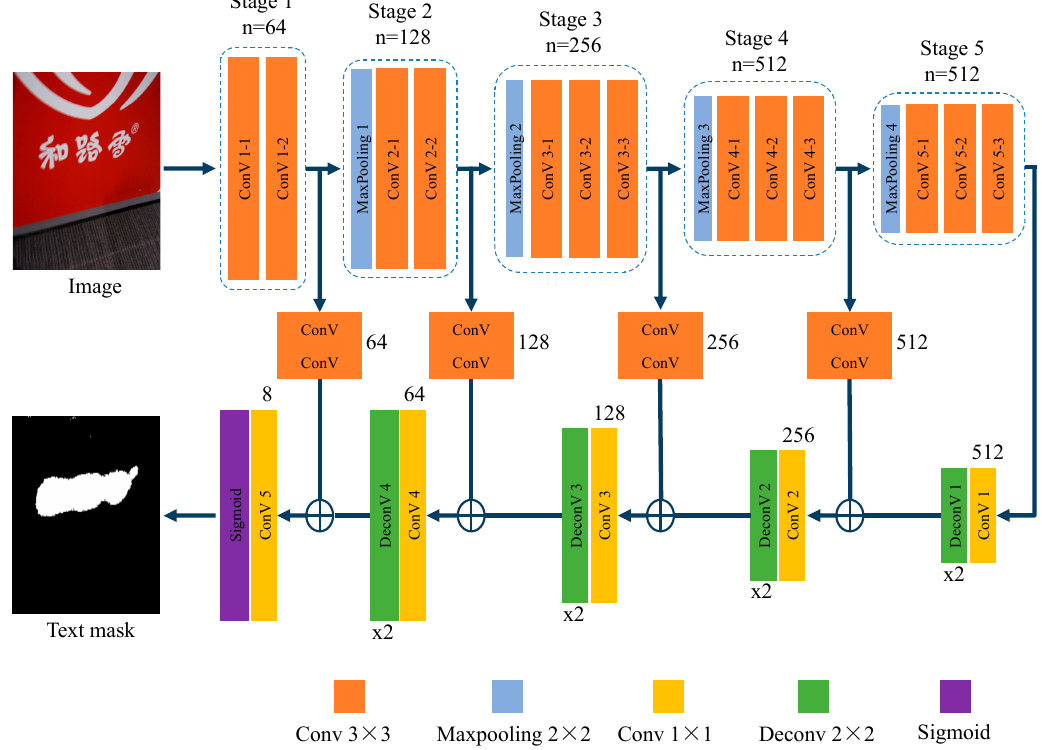
Figure 3. The architecture of our segmentation model. The final fusing feature map is in the same resolution as the input image and is converted to the text mask. We use n represents the number of convolutional kernels. The blue layers are Max-pooling, the orange are convolutional layer with 3 × 3 kernel size, the yellow are convolutional layer with 1 × 1 kernel size, the green is deconvolution layer, and the purple is sigmoid operation.